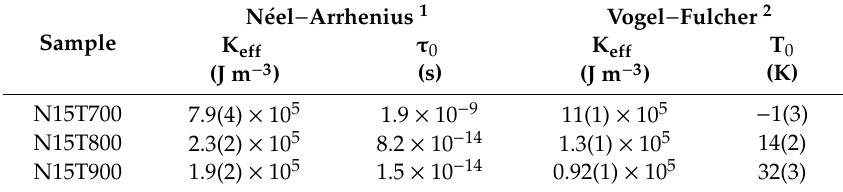
Figure 2. ( a ) Logarithm of the measurement time τ m versus 1/ T B and its linear fit (dashed line); ( b ) e ff ective anisotropy constant K e ff of N15T700, N15T800 and N15T900 obtained from fitting ln ( τ m ) versus 1/ T B by Ne é l–Arrhenius model (empty circles). The value from N5T900 was taken from reference [14] and that of bulk cobalt ferrite from reference [7]. Table 2. Magnetic parameters obtained from AC magnetic susceptibility measurements.